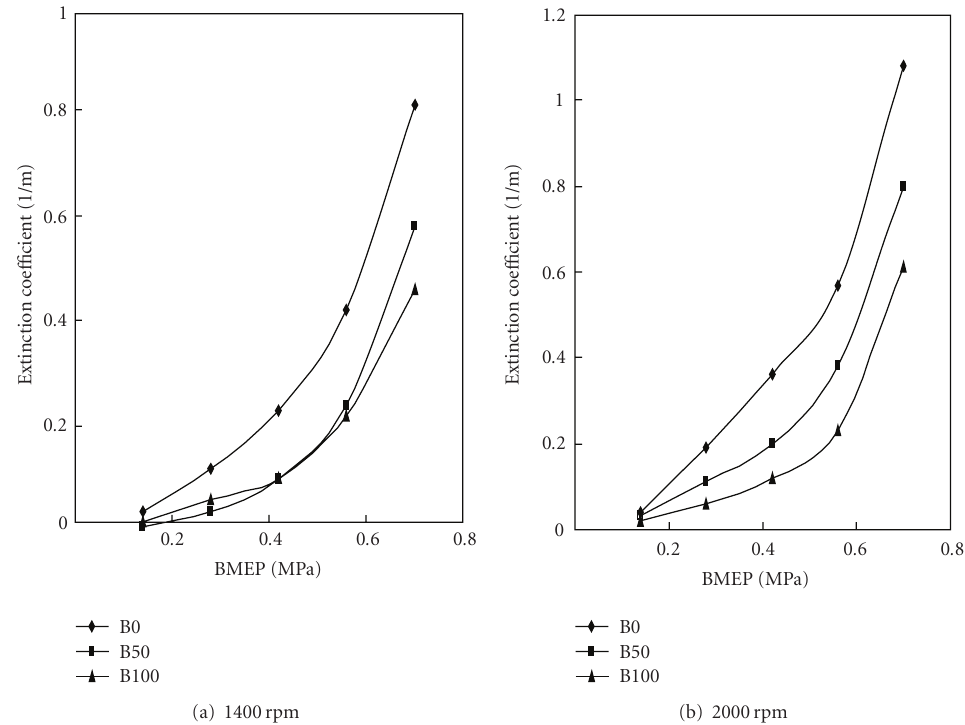
Figure 5: E ff ect of the rapeseed oil monoester on smoke emissions.